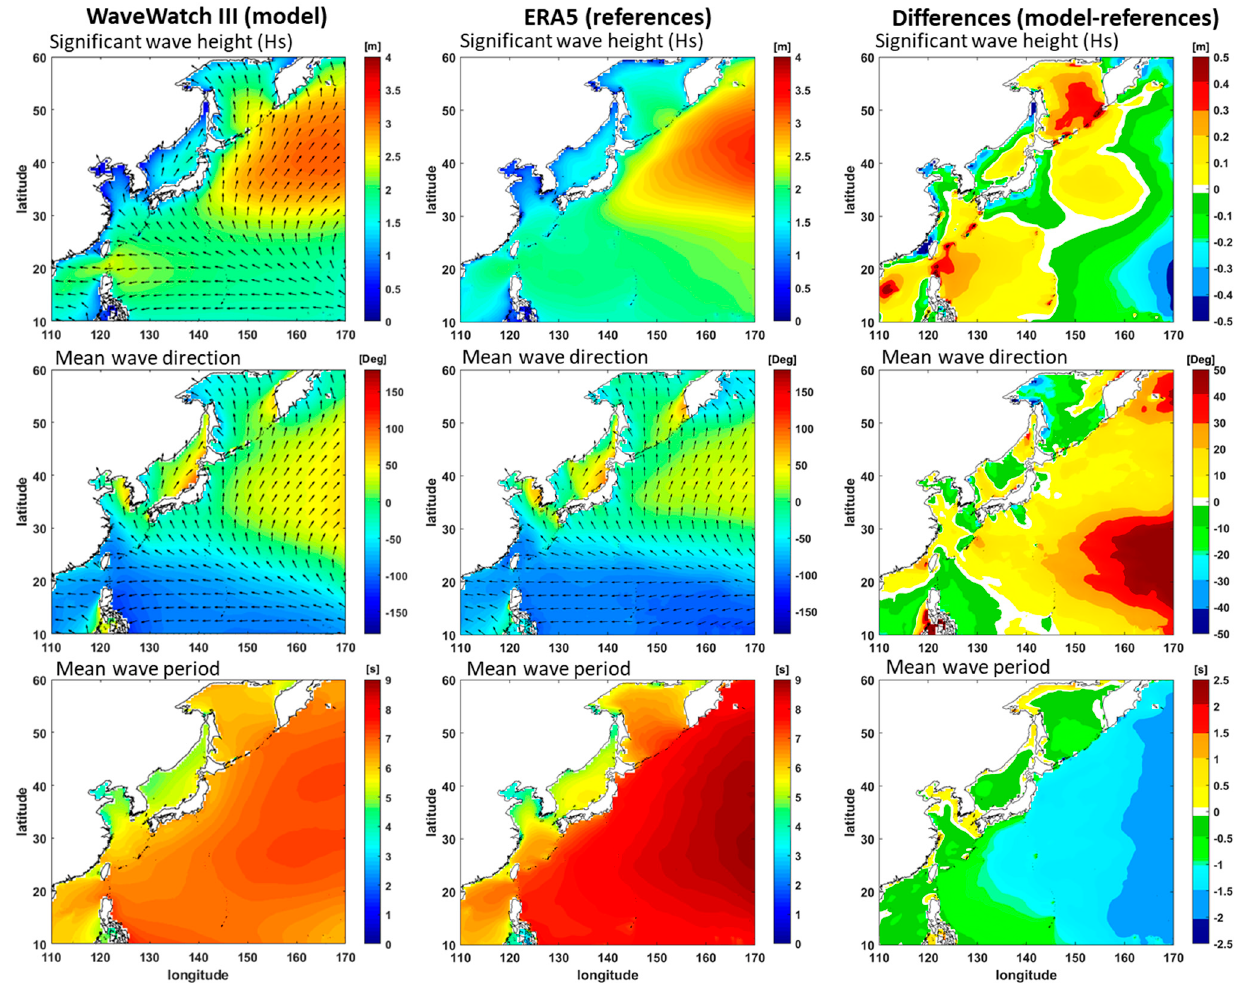
Figure 2. Comparison of wave characteristics for 2000, such as the mean significant wave height, mean wave direction, and mean wave period, between the AMIP scenario result simulated by WWIII with the CMIP6 marine surface winds (left column) and the ERA5 reanalysis wave dataset (middle column) and the difference between the two (right column).